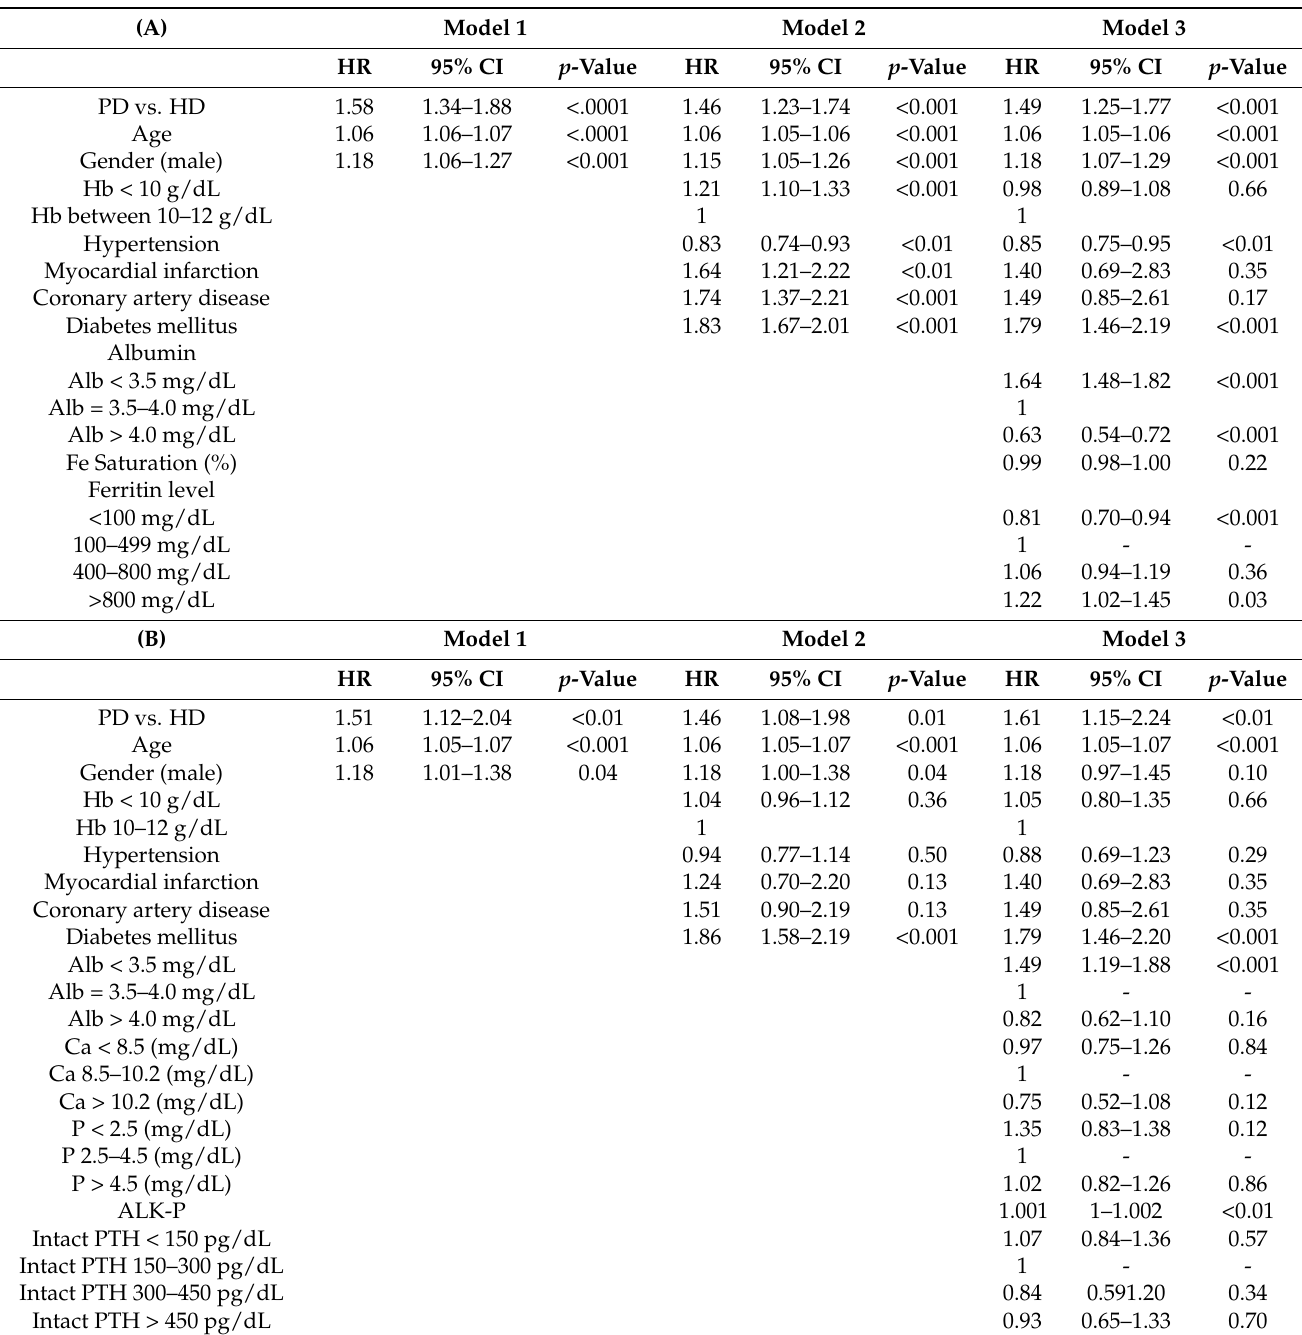
Table 2. ( A ) Hazard ratio (HR) of 3-year all-cause mortality in the whole population. ( B )